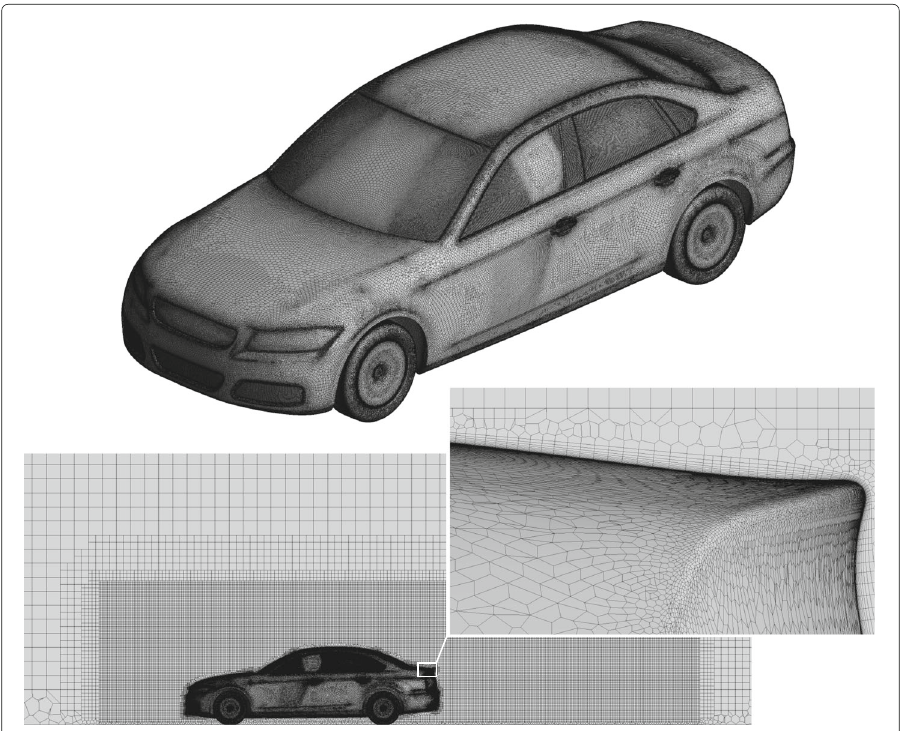
Fig. 5 Surface mesh of the notchback DrivAer model and mid-plane mesh with close-up of the boundary